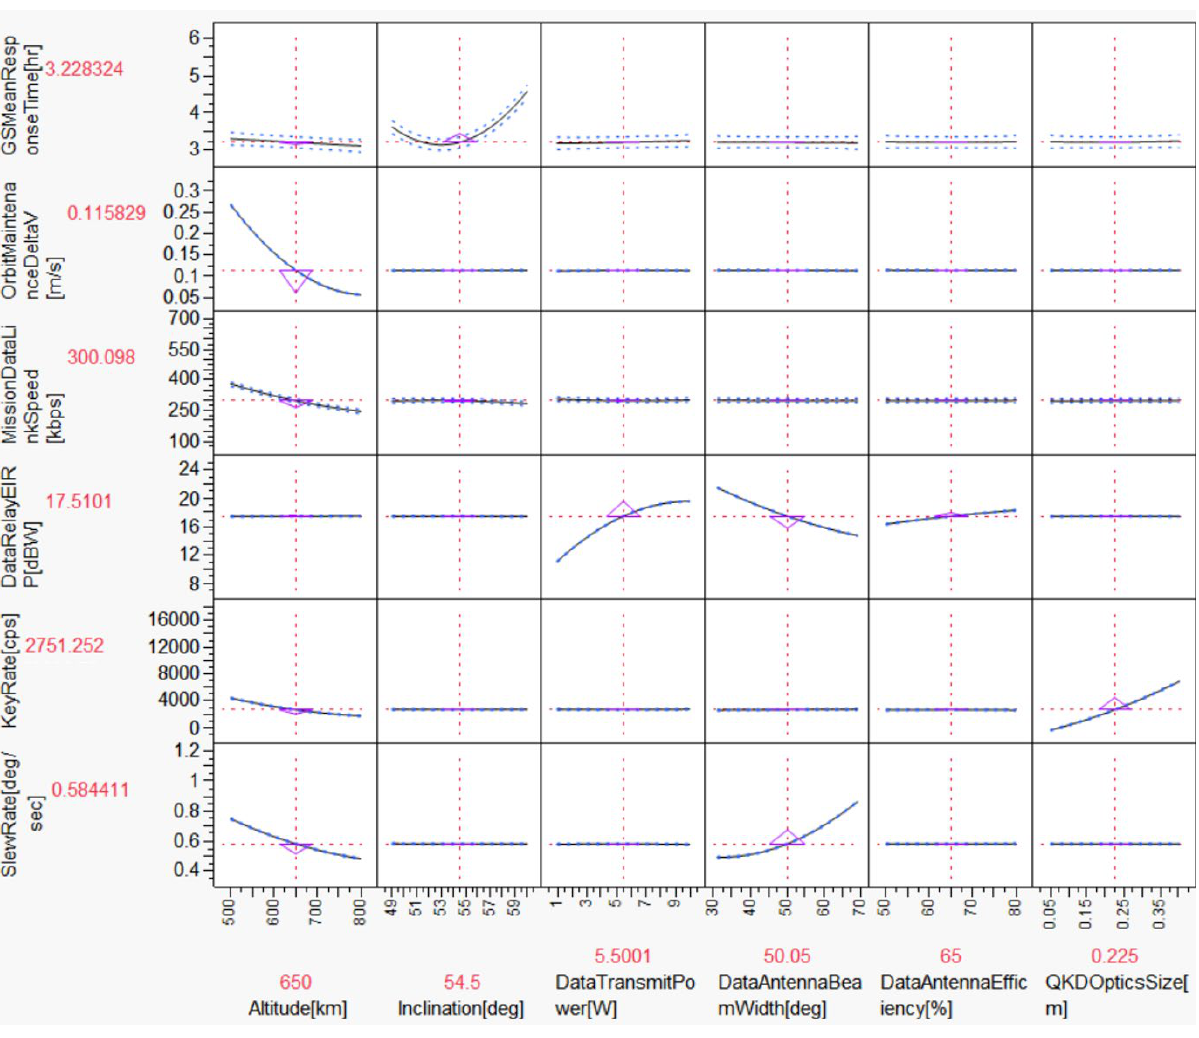
Figure 8. Example of a prediction profiler.